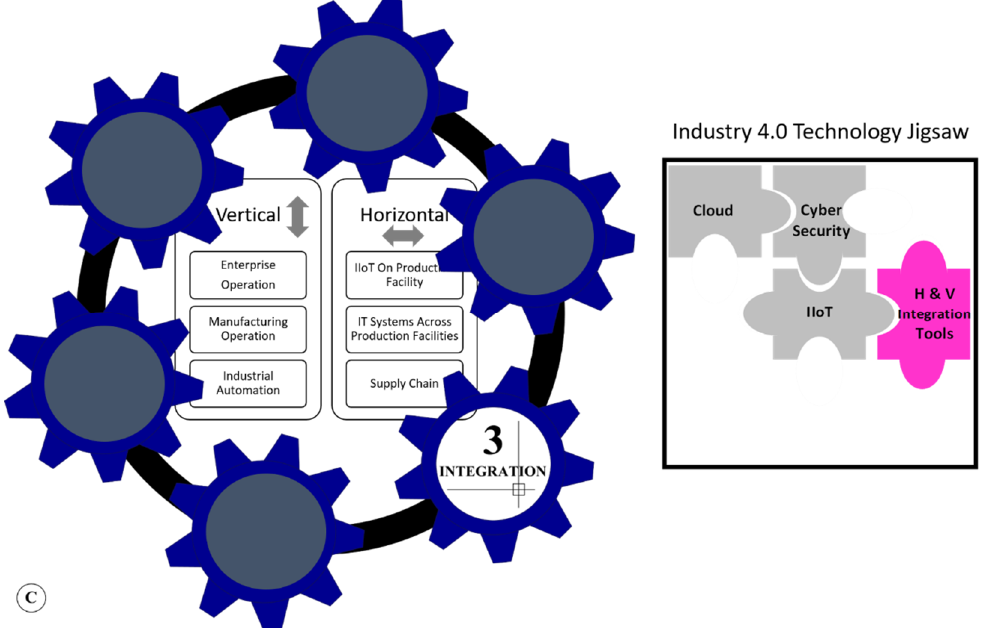
Figure 8. Gear 3—integration stage and Industry 4.0 technology jigsaw. (Primary technologies represented in color, sec- ondary technologies represented in